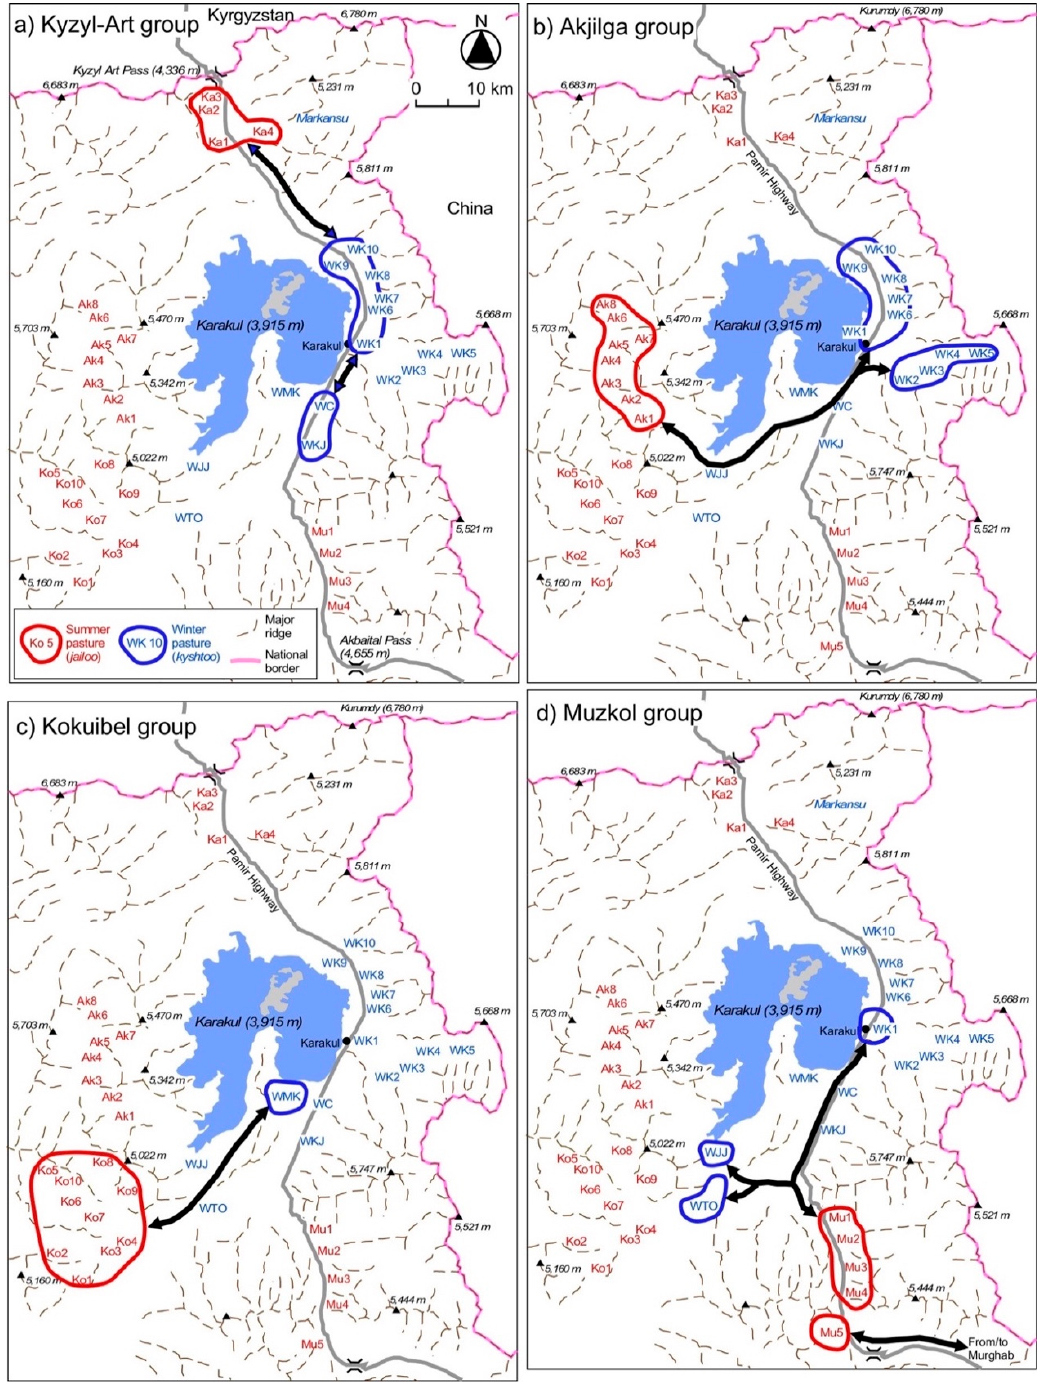
Figure 5. The major movement patterns between jailoo (summer pastureland) and kyshtoo (winter pastureland).